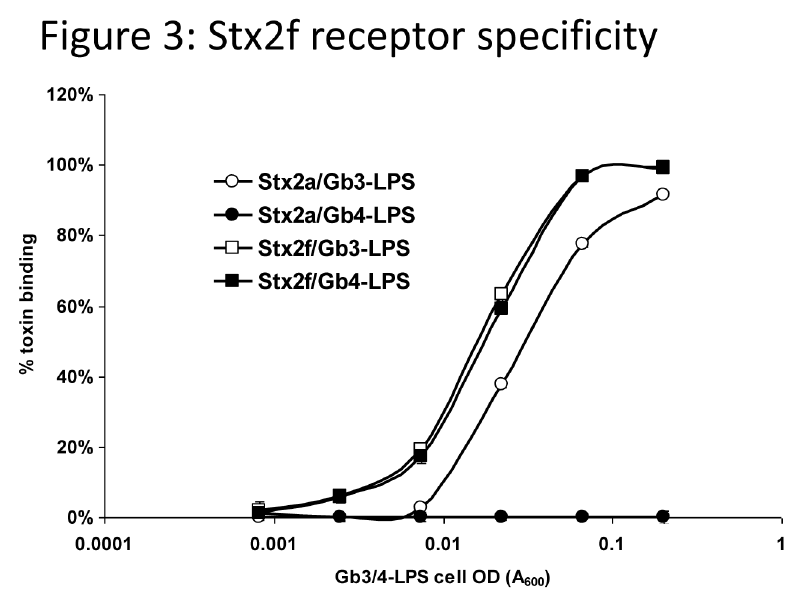
Figure 3. Binding of Stx2f to Gb3-LPS and Gb4-LPS receptors. Various amounts of Gb3-LPS- or Gb4-LPS-expressing cells were mixed with a fixed amount of purified Stx2f or Stx2a (250 pg/mL) in a microtube. Unbound toxins were recovered after centrifugation and quantified by ELISA using a mAb pair (Stx2f-1/4 for Stx2f or Sifin A/B for Stx2a). Stx2f binds to Gb3-LPS and Gb4-LPS cells with equal affinity, while Stx2a binds only Gb3-LPS cells. The average of three replicates of a representative experiment is shown (this experiment was conducted three